Question: Sum up the contents of this chart in one sentence.
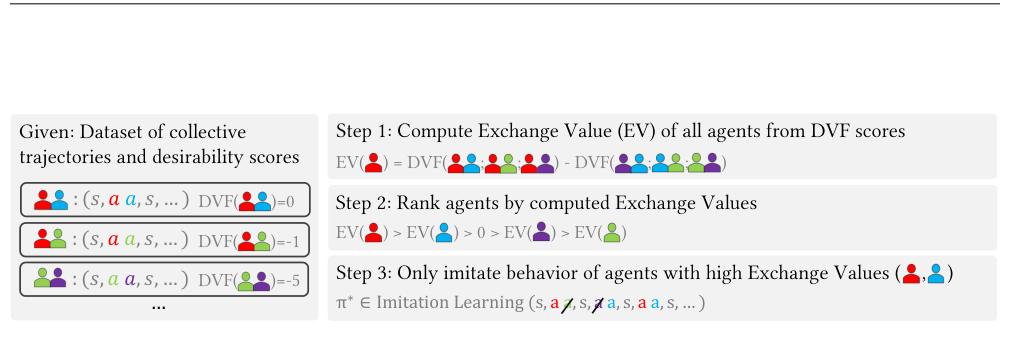
Answer: We are given a dataset composed of multi-agent trajectories generated by many individual agents, e.g., a dataset of cars driving in urban environments. In addition, the Desired Value Function (DVF) indicates the desirability score of a collective trajectory, e.g., the number of incidents that occurred. We first compute the Exchange Value (EV) of each agent, where a positive EV indicates that an agent increases the desirability score (e.g. an agent driving safely). We reformulate imitation learning to take into account the computed EVs, and achieve an imitation policy that is aligned with the DVF (e.g. only imitating the behavior of safe drivers).